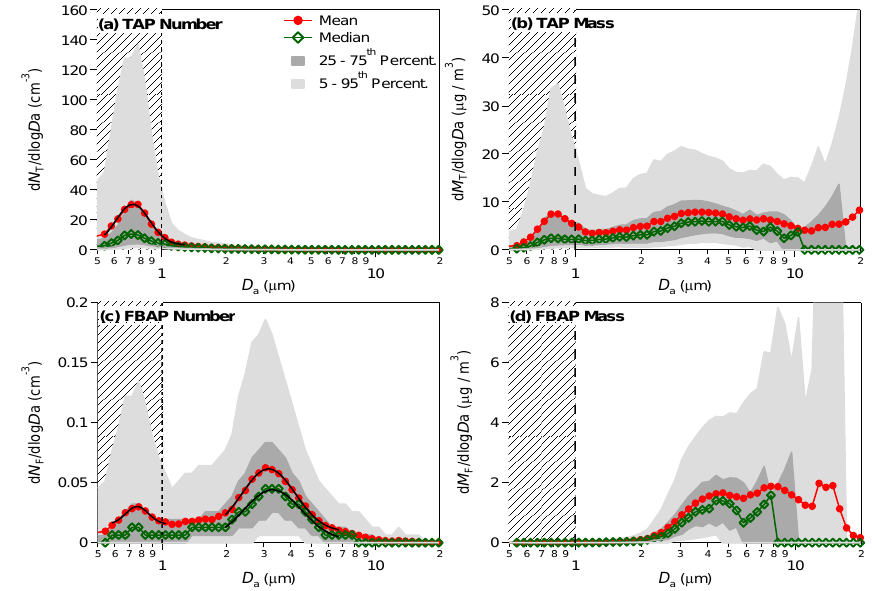
Fig. 10. Average particle number and mass size distributions for the entire measurement period. Red traces represent mean values, green traces represent median values, dark gray regions show 25–75th percentile range, and light gray regions show 5–95th percentile range. Hatched area below 1.0µm indicates particle size range where fluorescent particles were not considered FBAP due to interference with non-biological aerosol. Black traces are lognormal fits to individual peaks with the following fit parameters: (a) TAP number (d N T /dlog D a ): Fit N T -1: D a =0.54–1.3µm; D a , g =0.74µm, σ g =1.20, N =5.3cm − 3 , (b) TAP Mass (d M T /dlog D a ) ; (c) FBAP Number (d N F /dlog D a ) ; Fit N F -1(mean): D a =0.58–1.0µm; D a , g =0.76µm, σ g =1.13, N =2.0 × 10 − 3 cm − 3 ; Fit N F -2 (mean): D a =2.0–6.7µm; D a , g =3.2µm, σ g =1.33, N =1.6 × 10 − 2 cm − 3 , Fit N F -3 (median): D a =2.0–6.7µm; D a , g =3.3µm, σ g =1.36, N =1.4 × 10 − 2 cm − 3 ; (d) FBAP Mass: d M F /dlog D a